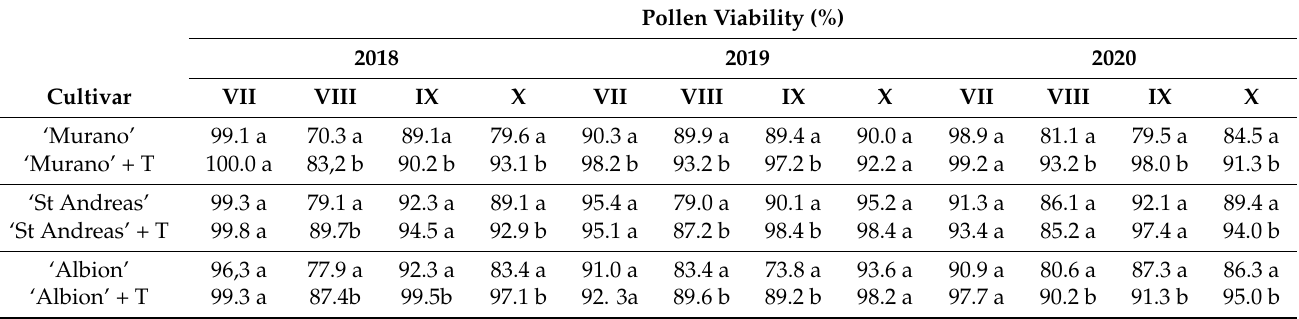
Table 1. The effect of titanium organic complex application on the viability of pollen grains of three strawberry cultivars